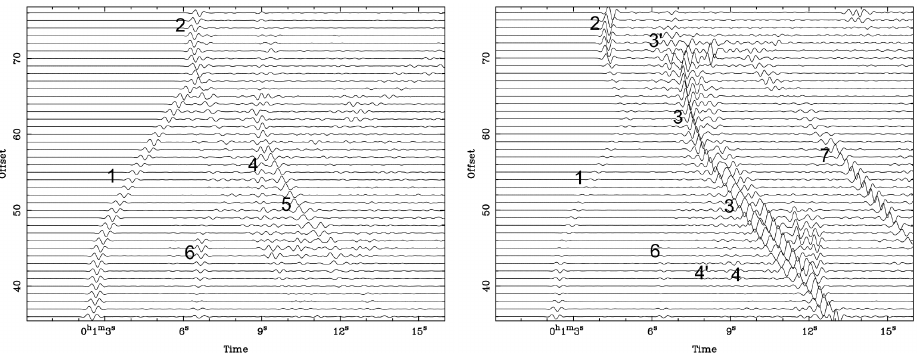
Fig. 12: Time-reduced synthetic horizontal component record sections for the model with DSC and explosive sources located below the oceanic crust (left panel) and inside the DSC (right panel). In the former case, the record section exhibits a “no DSC”-signature (compare to Fig. 9), in the latter case, it exhibits a clear “DSC” signature (compare to Fig. 10). Phases are numbered consistent with Figs. 9 and